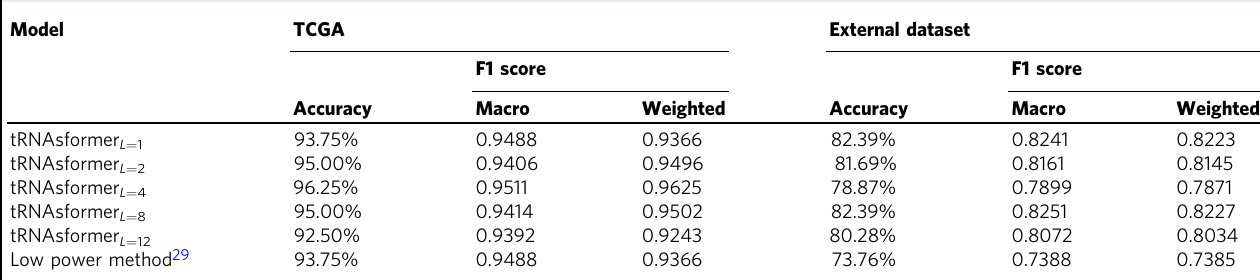
Table 3 The accuracy, macro, and weighted F1 scoes for classi fi cation on the TCGA test set and the external dataset for all classi fi cation